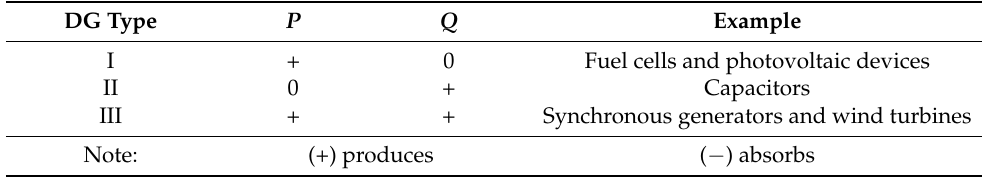
Table 11. Various DG types.